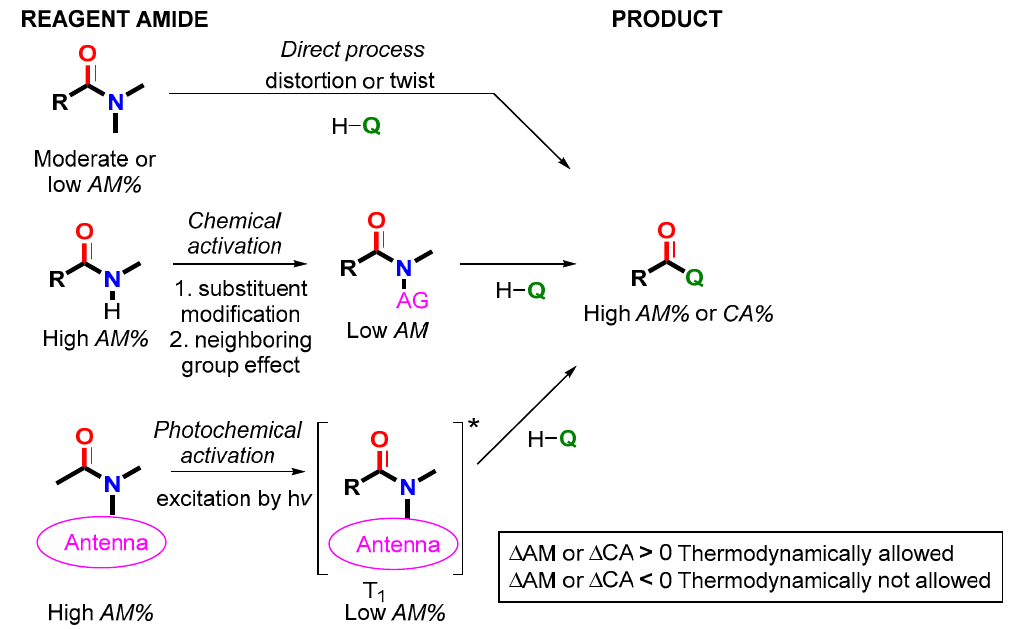
Figure 29. Summary of the amide activation processes. T 1 = triplet state; AM% = amidicity; CA% = carbonylicity.